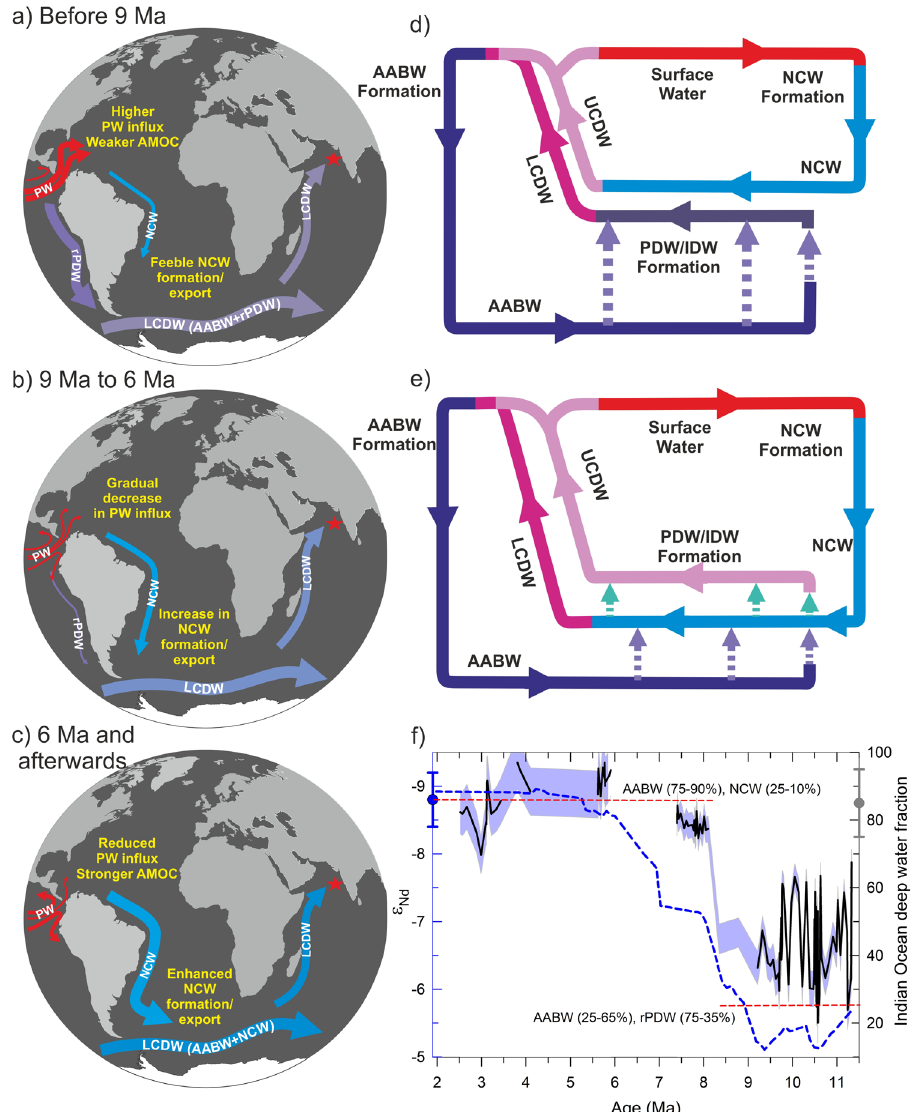
Fig.5|ConstrictionandshoalingoftheCASanditswidespreadimpactondeep watercirculationinthreedifferentstages.a Stage1(before~9Ma):largein fl uxof fresh PW into the north Atlantic Ocean resulted in weaker AMOC and reduced formationandexportofNCWtotheSouthernOcean,asaresultAABWmixed with rPDW to form the LCDW; b Stage 2 (~9Ma to 6Ma): gradual decrease in the PW in fl ux to the North Atlantic and increase in the NCW formation and export to the Southern Ocean; c Stage 3 (after ~6Ma): reduced export of PW into the north AtlanticandsubsequentstrengtheningofNCWformationandenhancedexport(as a resultof stronger AMOC) tothe SouthernOceanresultedinLCDWbeing formed by the mixture of AABW and NCW, while the rPDW formed the upper cell of the CDWowingtoitslesserdensitythanNCWsimilartomoderntime;theseschematic